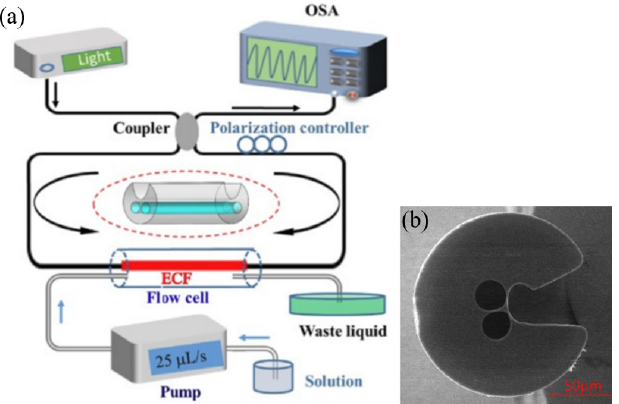
Figure 9. ( a ) The schematic diagram of an ECF-based SI biosensor system, and the ( b ) SEM image of ECF. Reprinted with permission from [124].